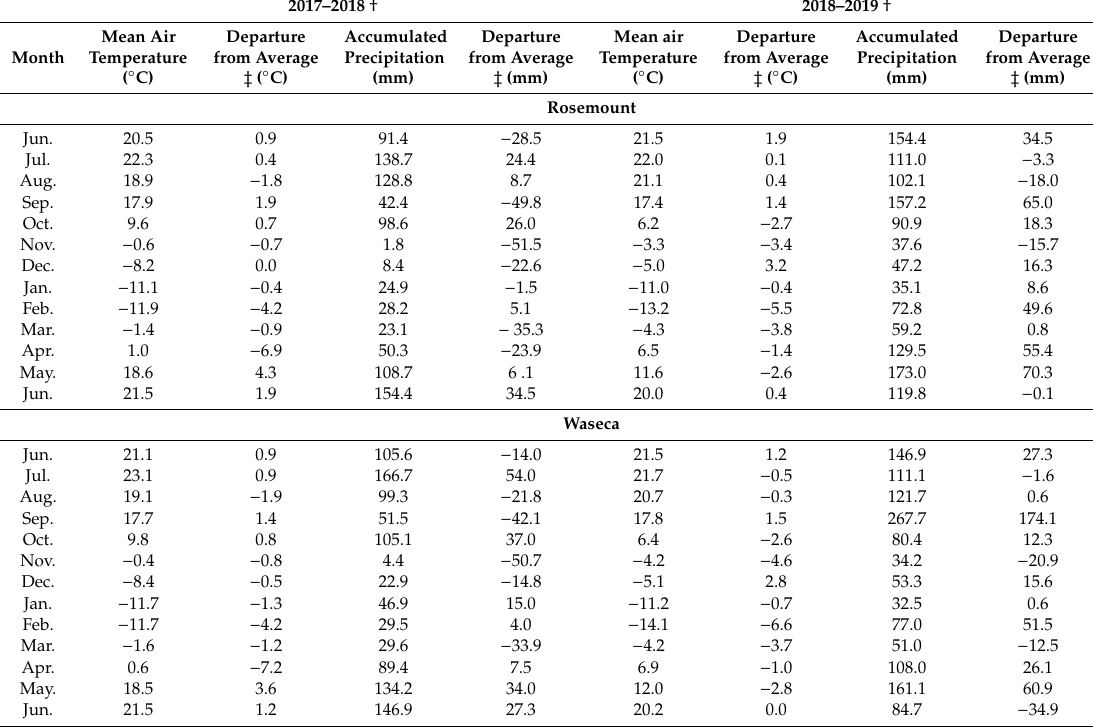
Table 1. Monthly climate data and departures from the 30-year average for Rosemount, MN over